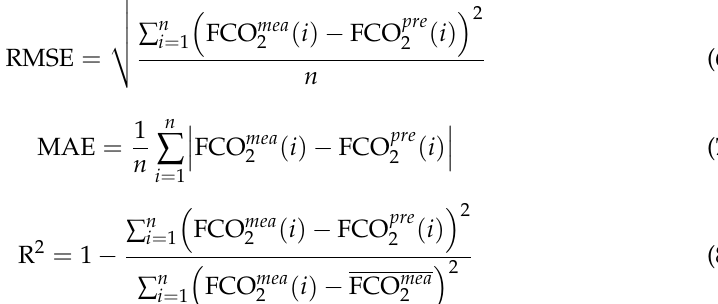
(Figure 2). Seasonally, the autumn FCO 2 averages 10.96 g C m − 2 day − 1 in CHD